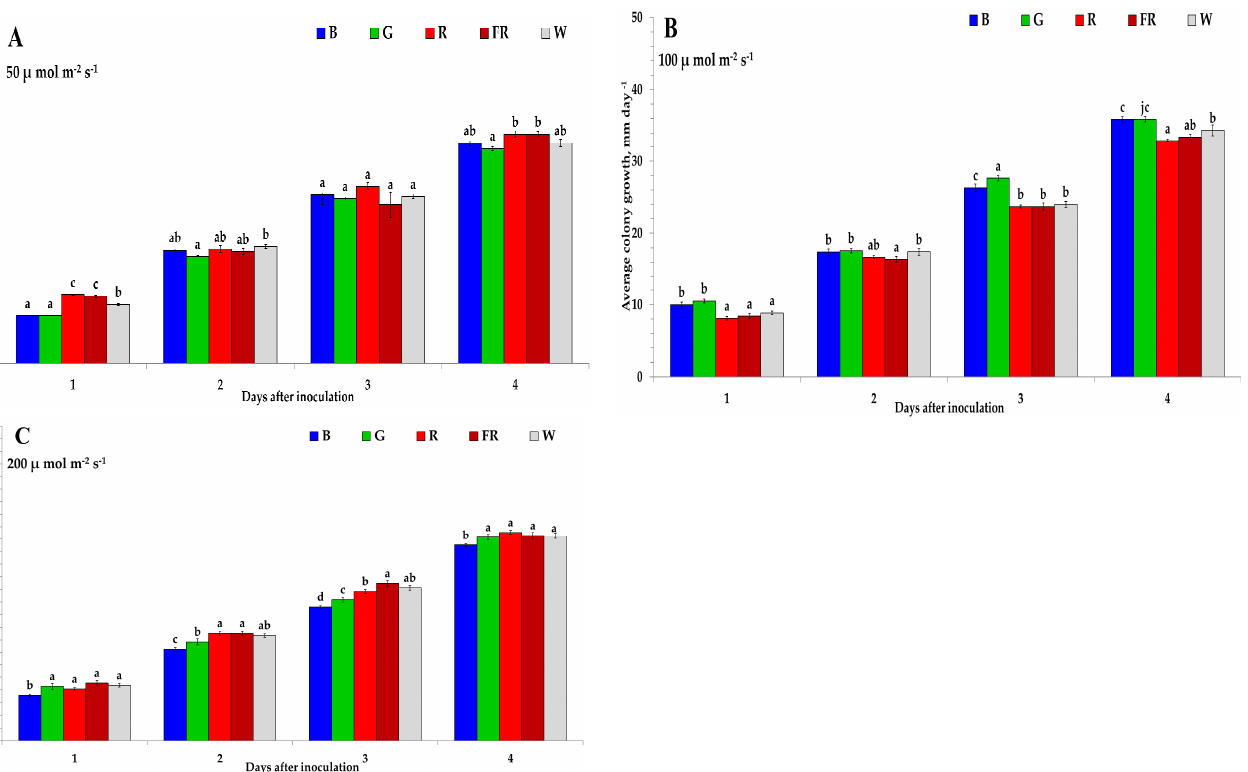
Figure 1. The average C. acutatum mycelium growth rate under various photosynthetic photon flux densities and LED light wavelength. ( A )—50 μ mol m −2 s −1 , ( B )—100 μ mol m −2 s −1 , ( C )—200 μ mol m −2 s −1 . B—blue (peak = 450 nm); G—green (peak = 530 nm); R—red (peak = 660 nm); FR—far red (peak = 735 nm); W—white (5700 K). The values in the figure are expressed as mean ± standard error ( n = 4). According to Duncan’s multiple range test, the means of different letters are significantly different at the p < 0.05 level.